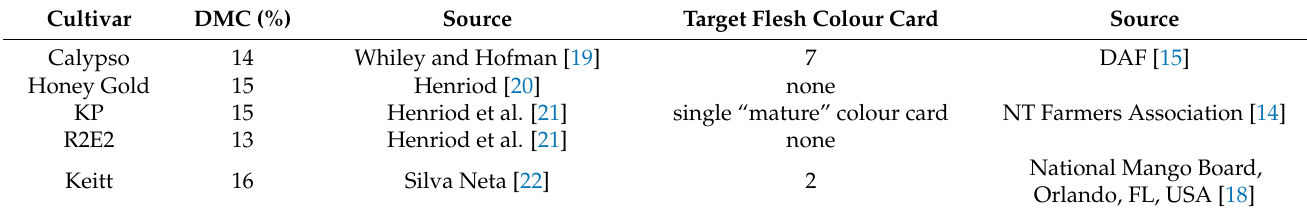
Table 2. Specifications on harvest minimum Dry Matter Content (DMC) and flesh colour for some relevant Australian grown mangoes. Flesh colours refer to colour cards produced by the named source. Kensington Pride is abbreviated to